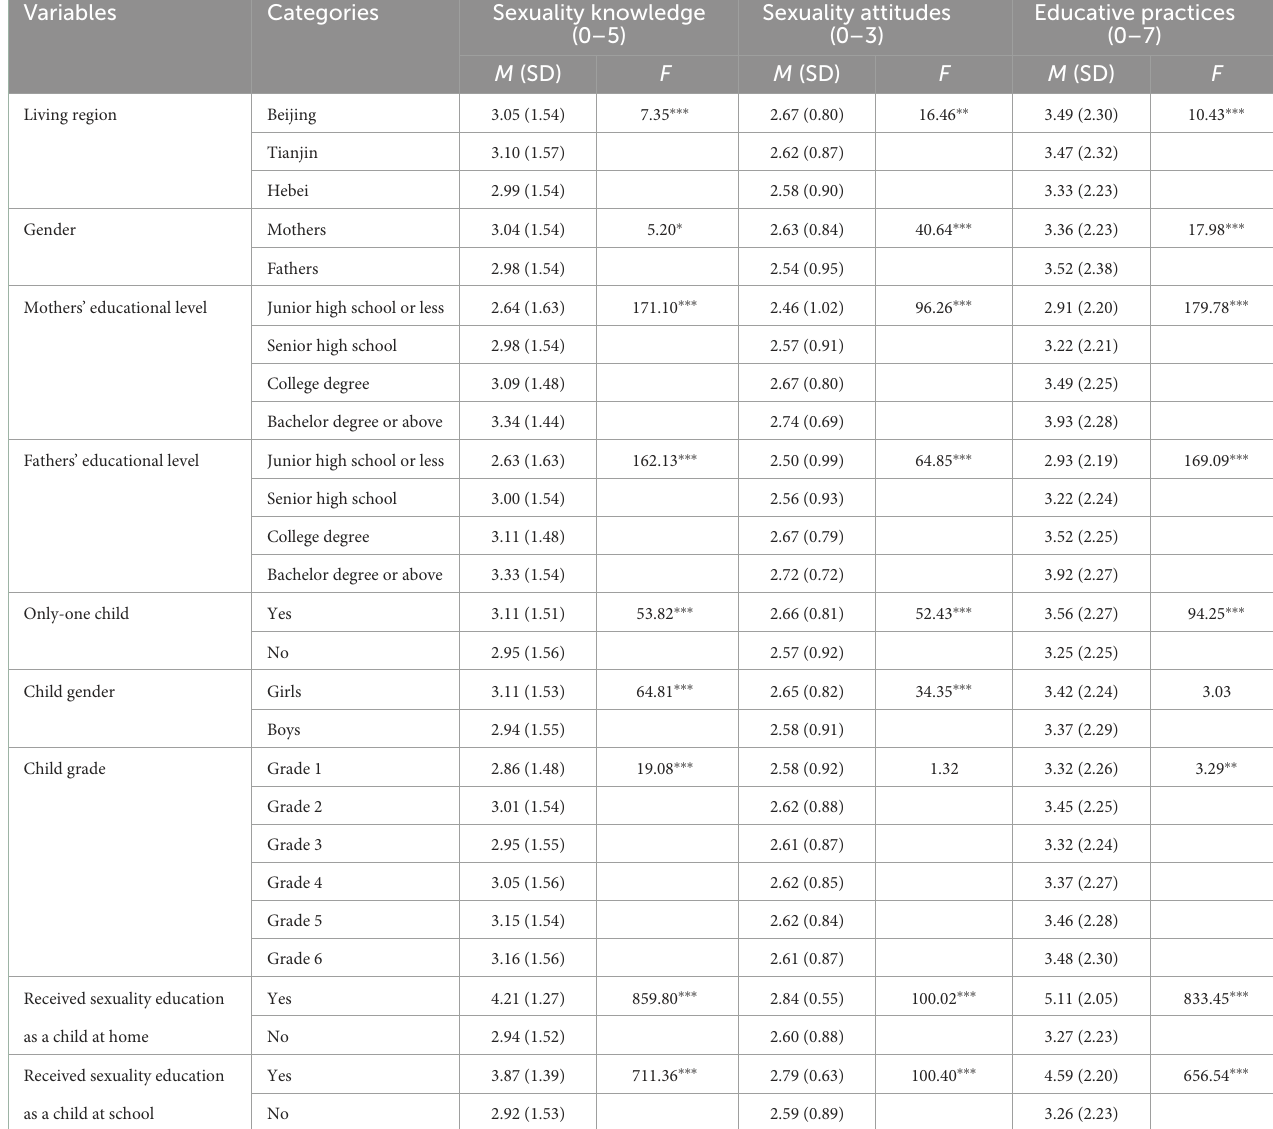
TABLE 5 Associations between demographic factors and parental sexuality knowledge, attitudes, and educative practices ( N = 19,745).